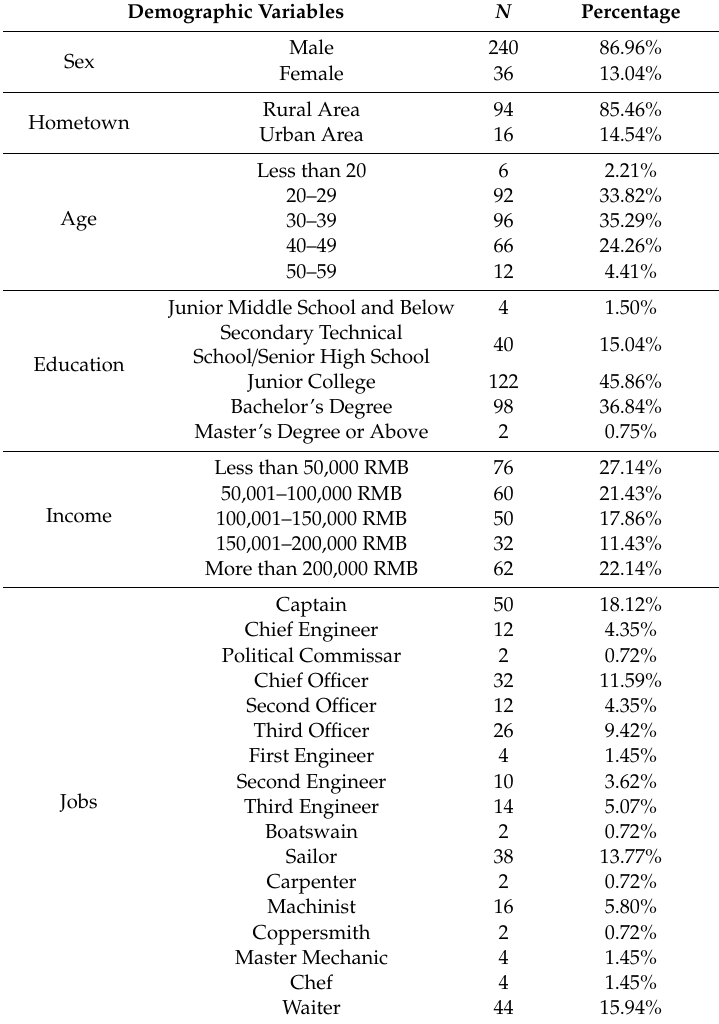
Table 1. Sample Information ( N =